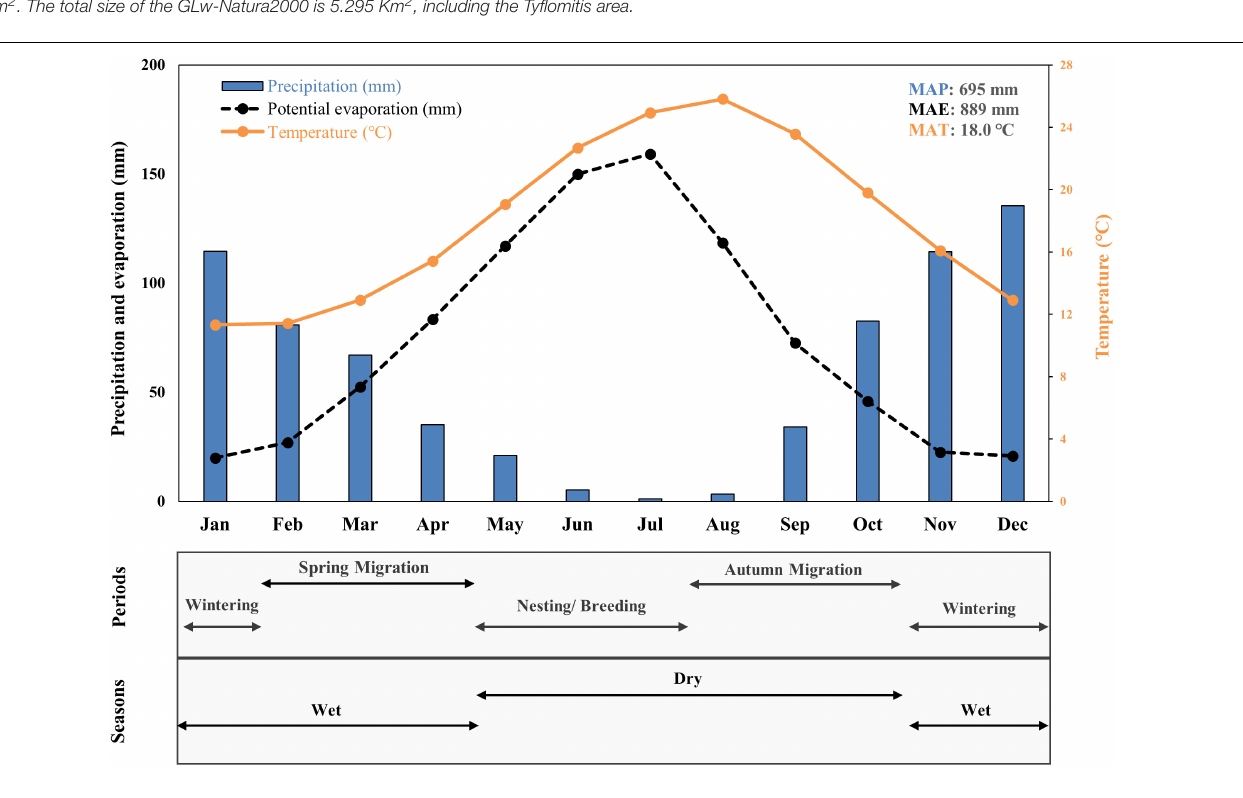
2017 counts, the rest of the counts were conducted by the same two